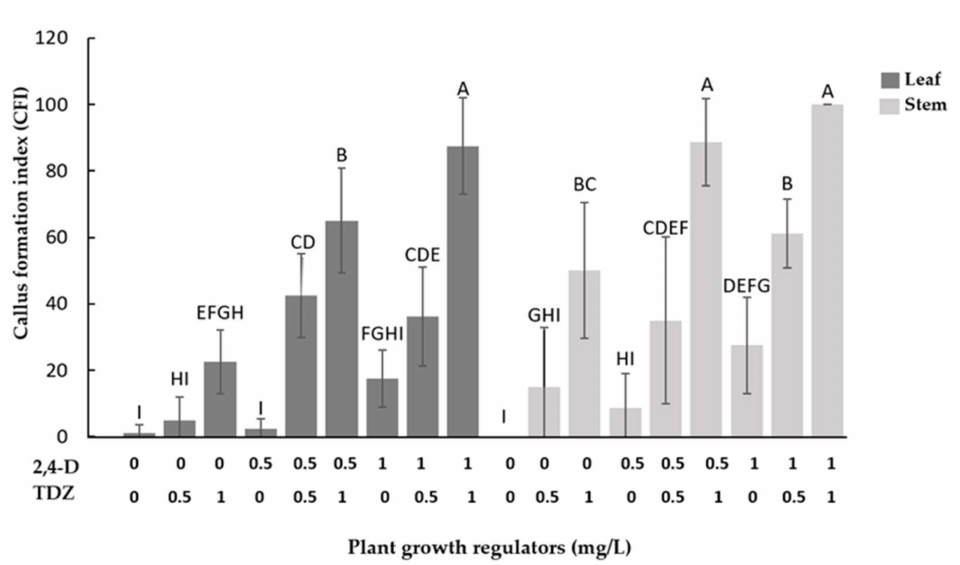
Figure 1. Effect of 2,4-D and TDZ on callus formation index (CFI) after 40 days of growth. Bars which do not share a common letter are significantly different ( p ≤ 0.05).